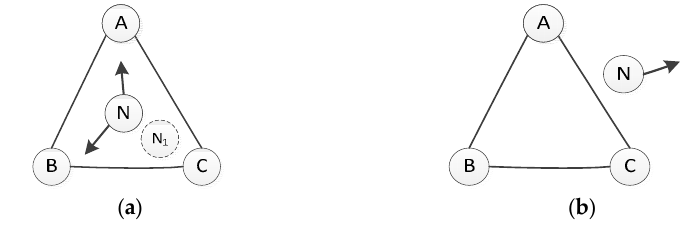
Figure 3. Format of the message broadcasted by anchor nodes.